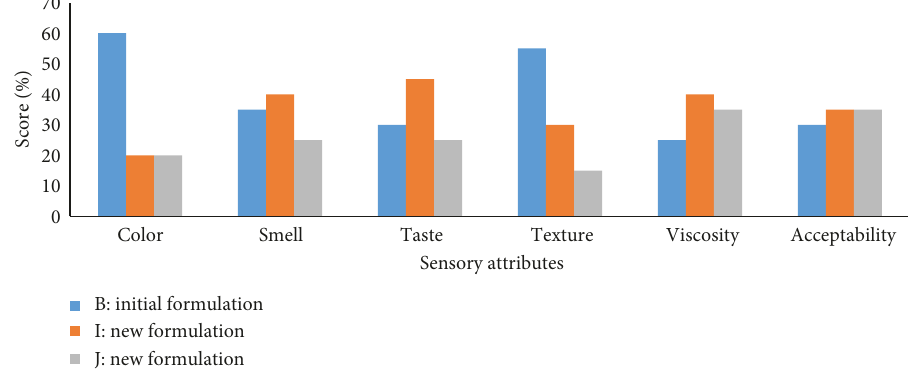
Figure 4: Preference ranking (%) of different Kapkerer’s family porridge against different sensory attributes. Table 3: Consumers’ reason for liking/disliking of developed porridges and factors considered attributed to preferences. Attributes